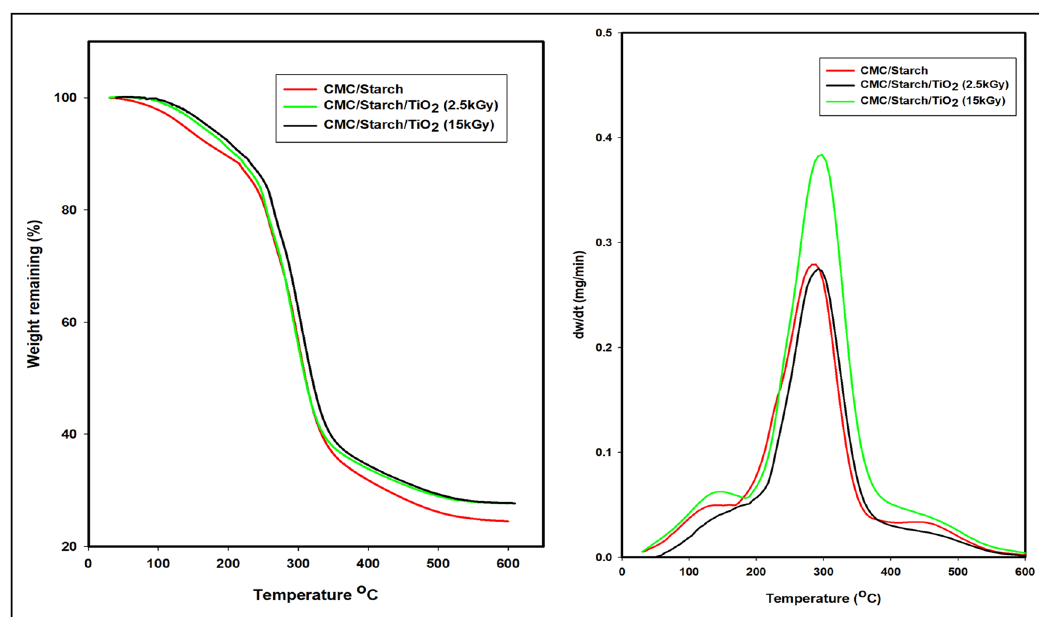
Figure 7: TGA thermograms and the rate of thermal decomposition ( d w /d t ) curves of CMC/starch and irradiated CMC/starch/TiO 2 at 2.5 and 15 kGy.